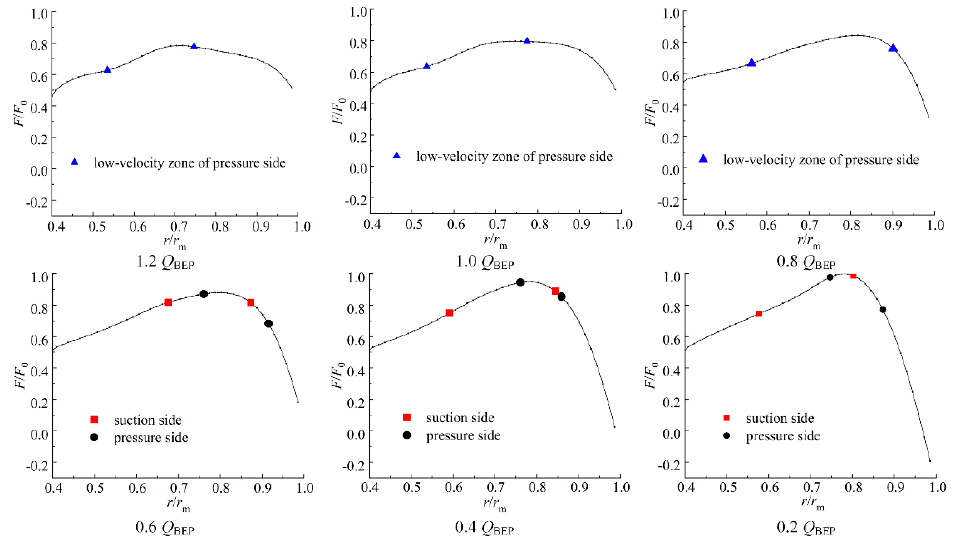
Figure 8. Blade load distribution and the position of the vortexes under different flow rates. For 0.2–0.6 Q BEP : the front point is the position of the leading edge of vortex, the back point is the position of the vortex center. For 0.8–1.2 Q BEP : the two points are the position of the leading edge and back edge of low-velocity-zone in the pressure side, respectively.